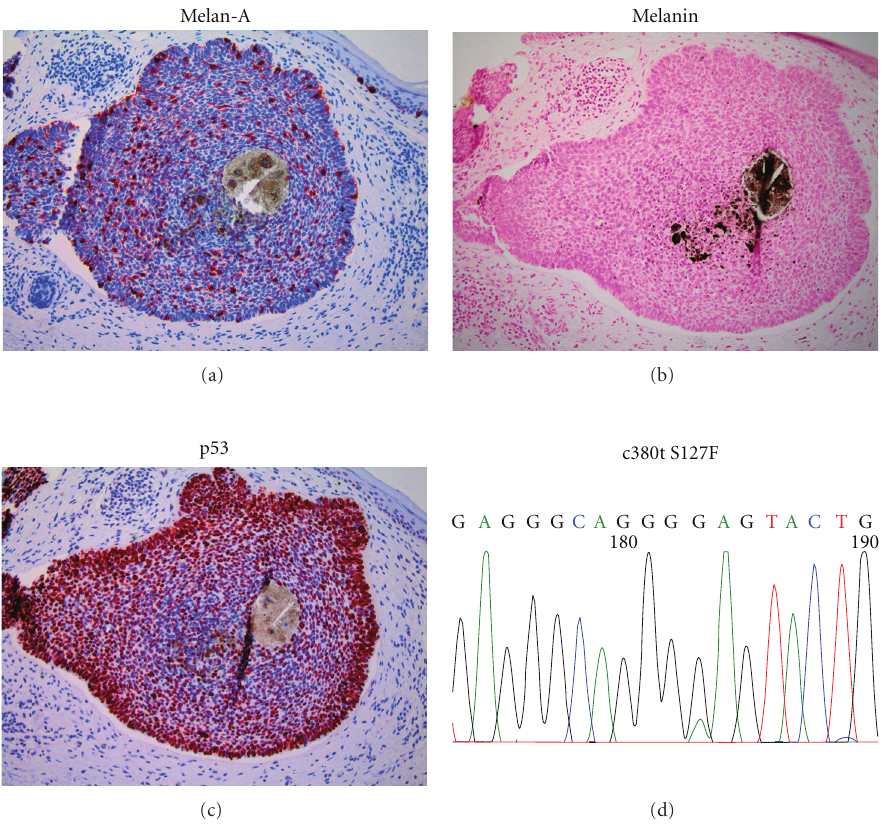
Figure 2: Melanocytic colonization in a BCC expressing mutant p53. Depicted are immunohistochemically stained tissue sections of a BCC displaying approximately 10% melan-A positive melanocytes (a) and high levels of nuclear p53 in 90% of the tumor cells (c). The specimen shows strong pigmentation in the centre of the lesion (b), and sequencing revealed the presence of a c380t mutation leading to an S127F amino acid exchange